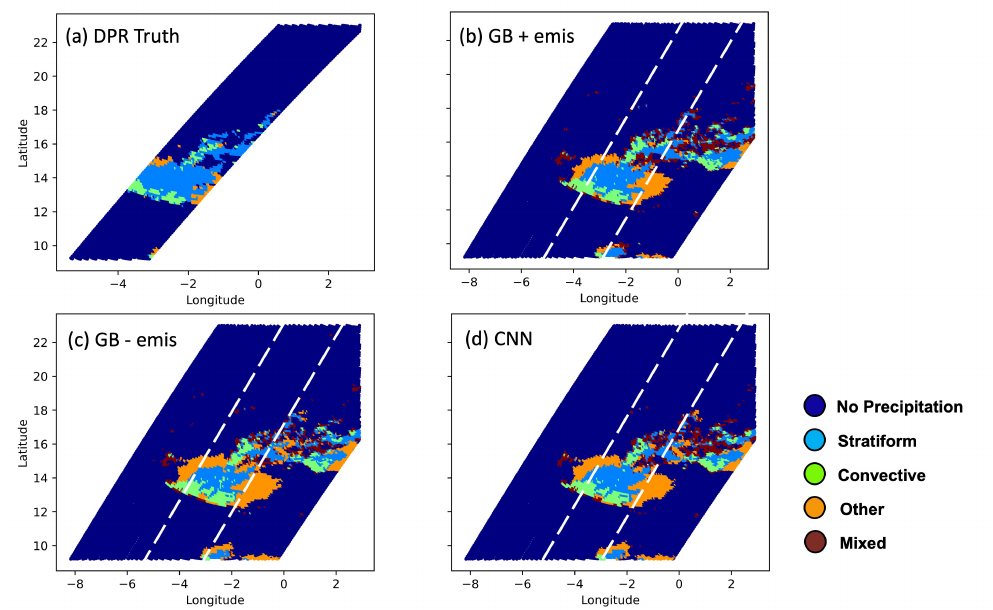
Figure 8. Precipitation types from ( a ) DPR “truth”; predicted from ( b ) GB+emis model; ( c ) GB-emis model; and ( d ) CNN model for a squall line event on 6 June 2017. The DPR swath is marked by the two white dashed lines in ( b – d ).